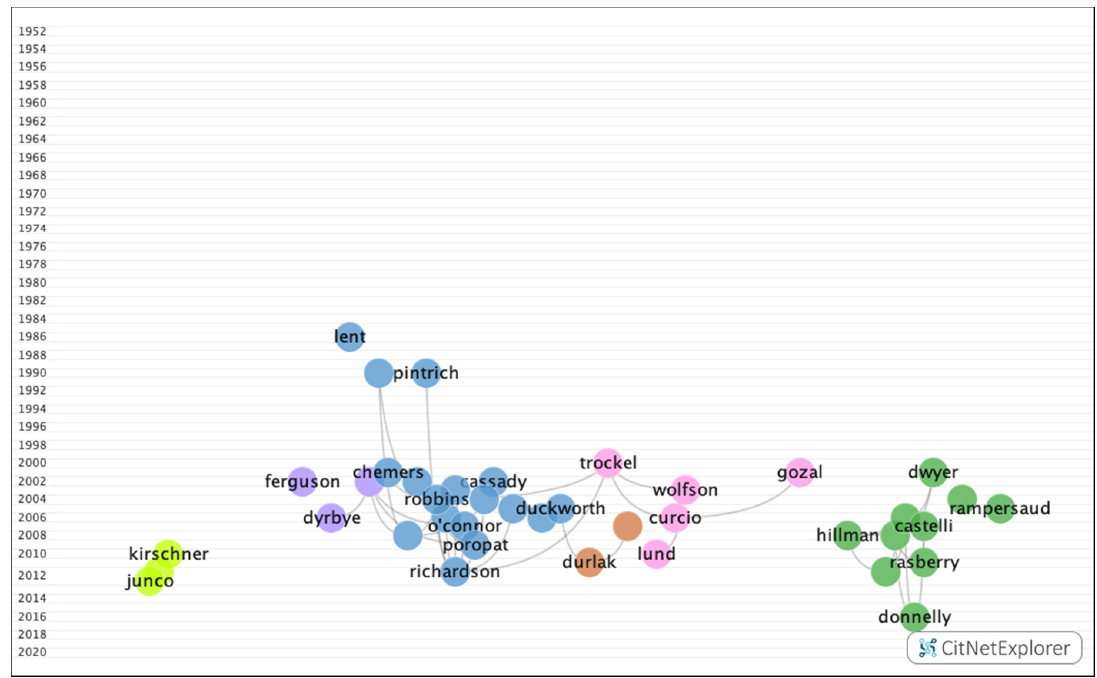
Figure 6. Clustering function in the network of citations on academic performance.